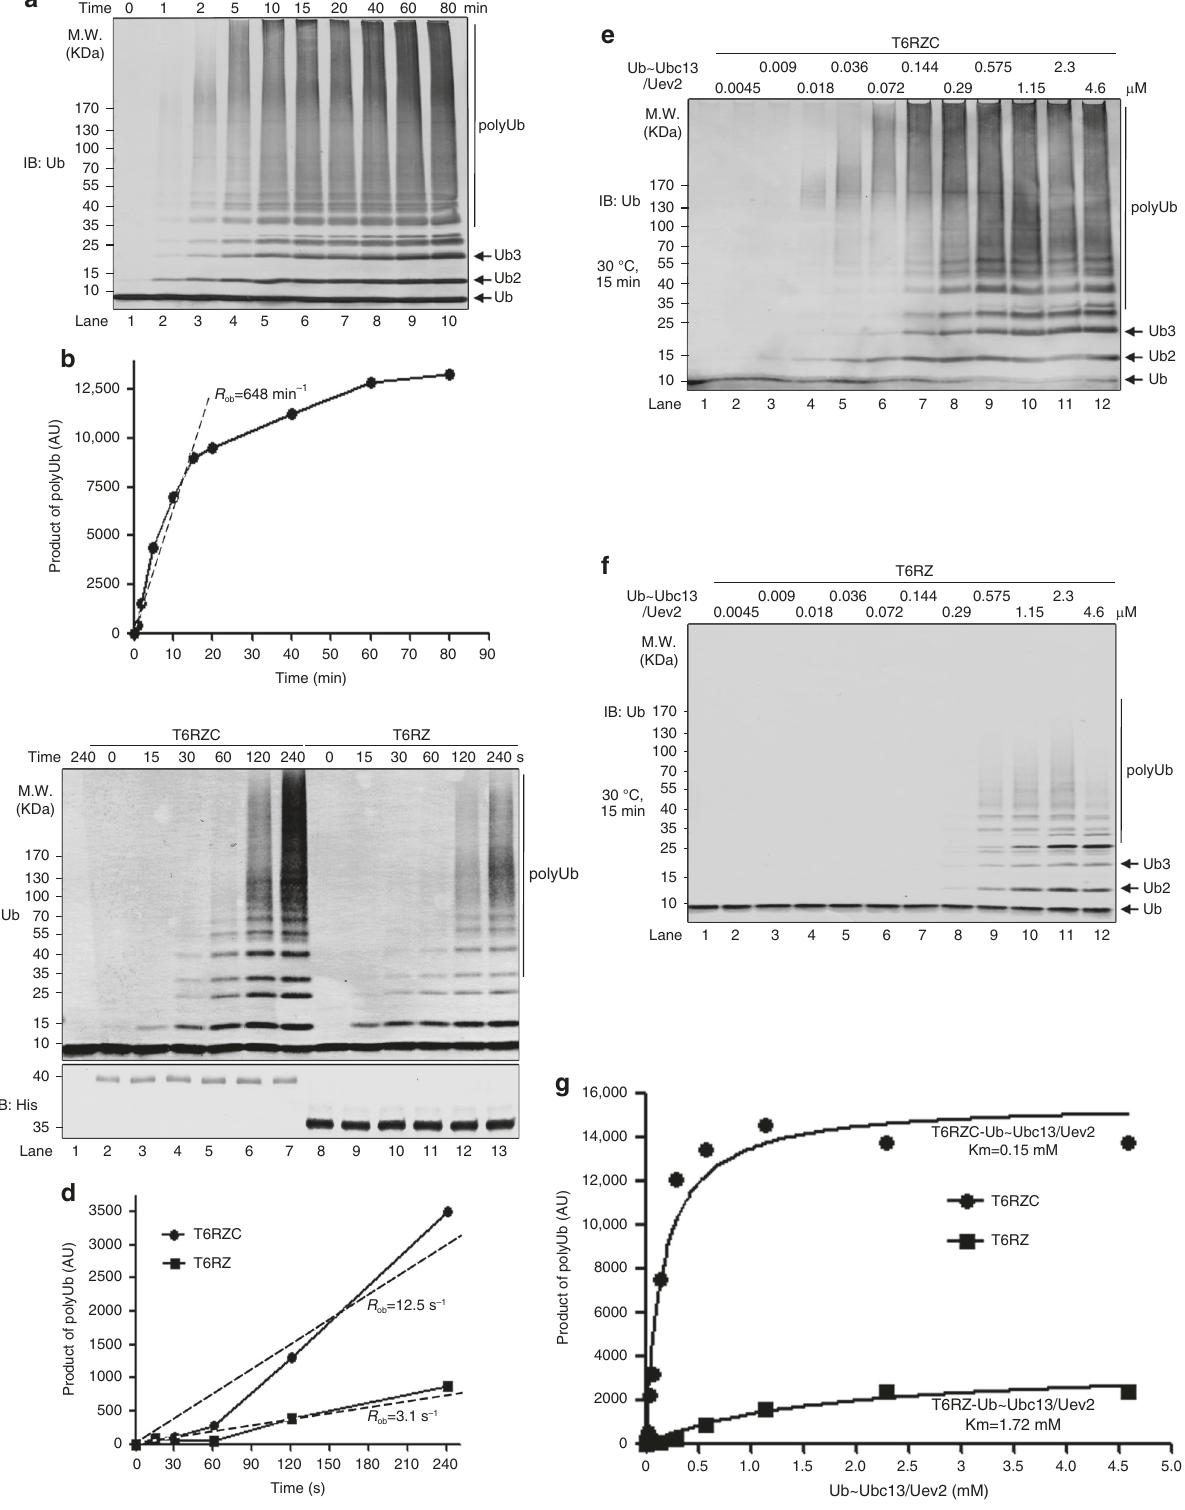
Fig. 1b) 10 . Size-exclusion chromatography separates proteins according to their molecular sizes. The fractions were visualized by immunoblotting using an anti-Ub antibody (Fig. 1c, bottom panel), which revealed separation of high molecular size polyUb chains from low molecular size ones (each fraction had its own characteristic molecular size distribution). TAK1 activation